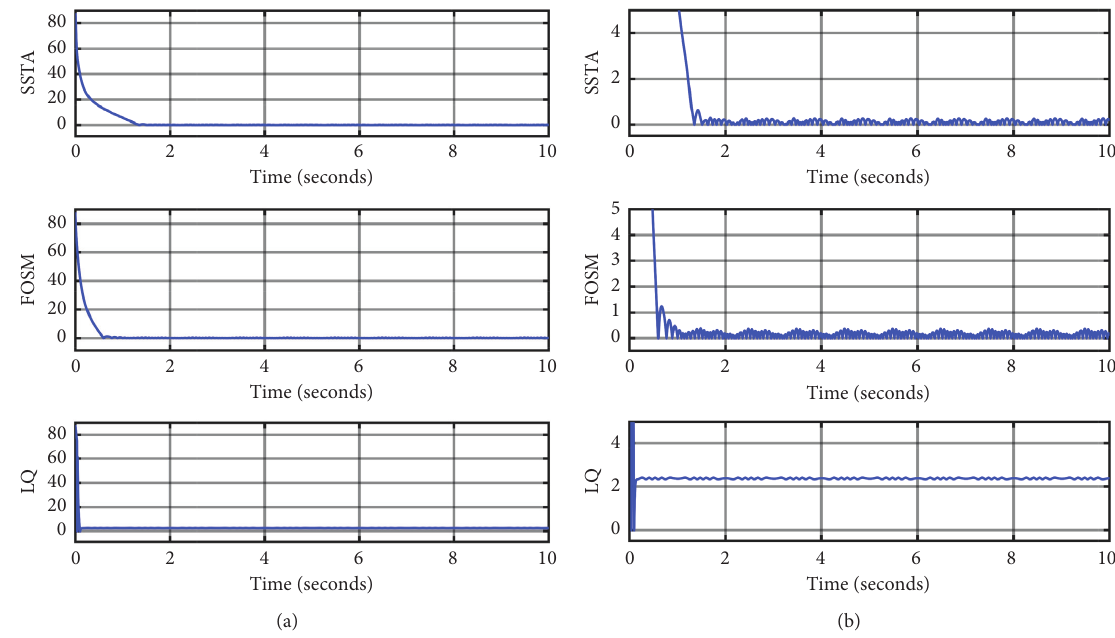
Figure 11: Voltage error tracking. (a) Voltage tracking error ‖ v ∗ − v ‖[ V ] . (b) Zoom.